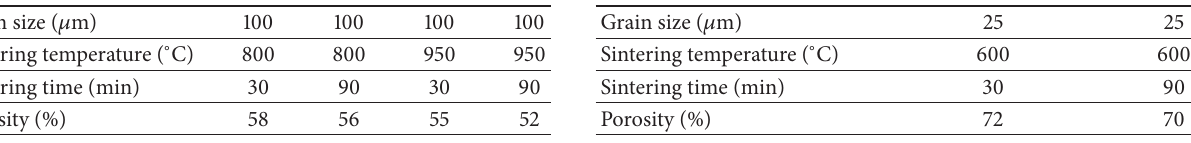
Table 2: Porosity of sintered structures from copper powder with grain size of 100 𝜇 m.